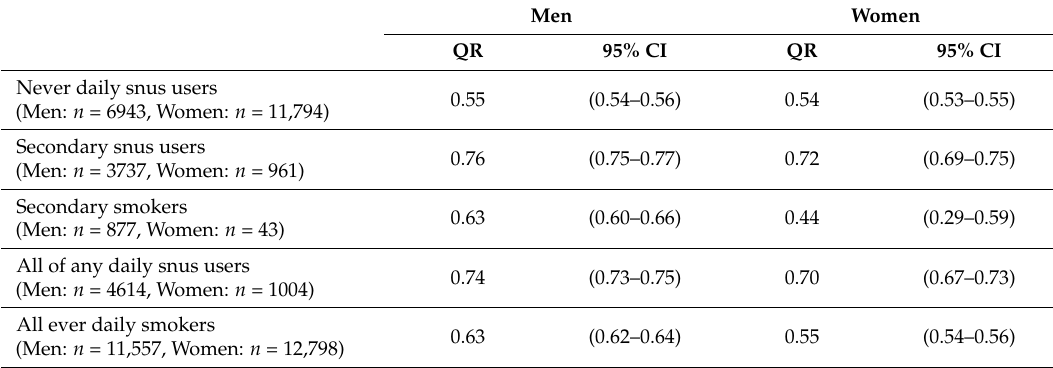
Table 3. Quit ratios for smoking—by gender and history of daily snus use. (Proportion of “Ever daily smokers” in different subgroups who have quit smoking completely at the time of the